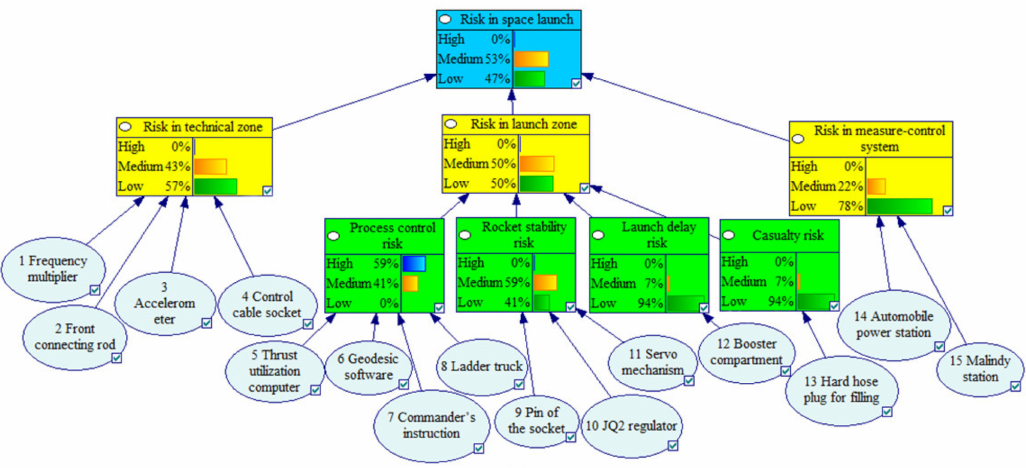
Figure 6. BN for the risks in a space launch.